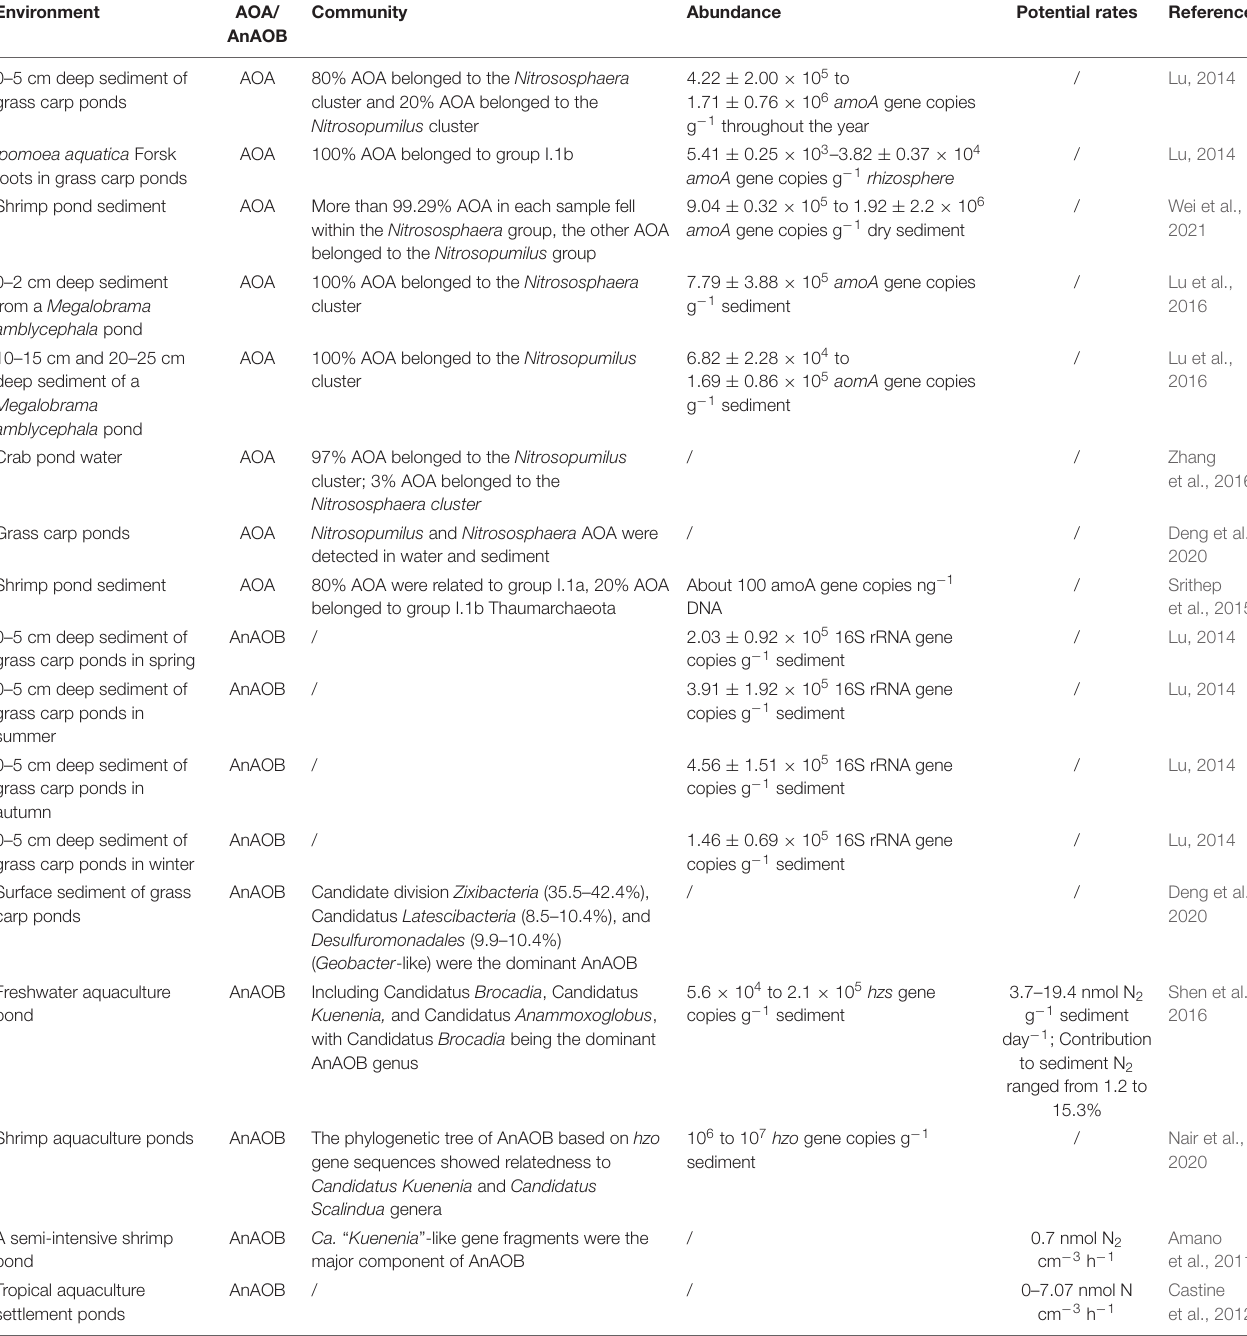
TABLE 1 | Studies on ammonia-oxidizing archaea (AOA) and anaerobic ammonia-oxidizing bacteria (AnAOB) in the pond environment. Environment AOA/ Community Abundance Potential rates AnAOB